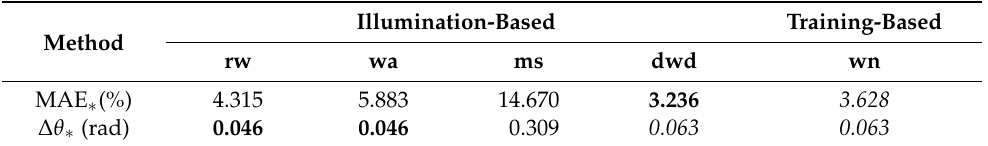
Table 1. The reflectance estimation errors. Bold shows the best result and italics the second best one. Illumination-Based Method